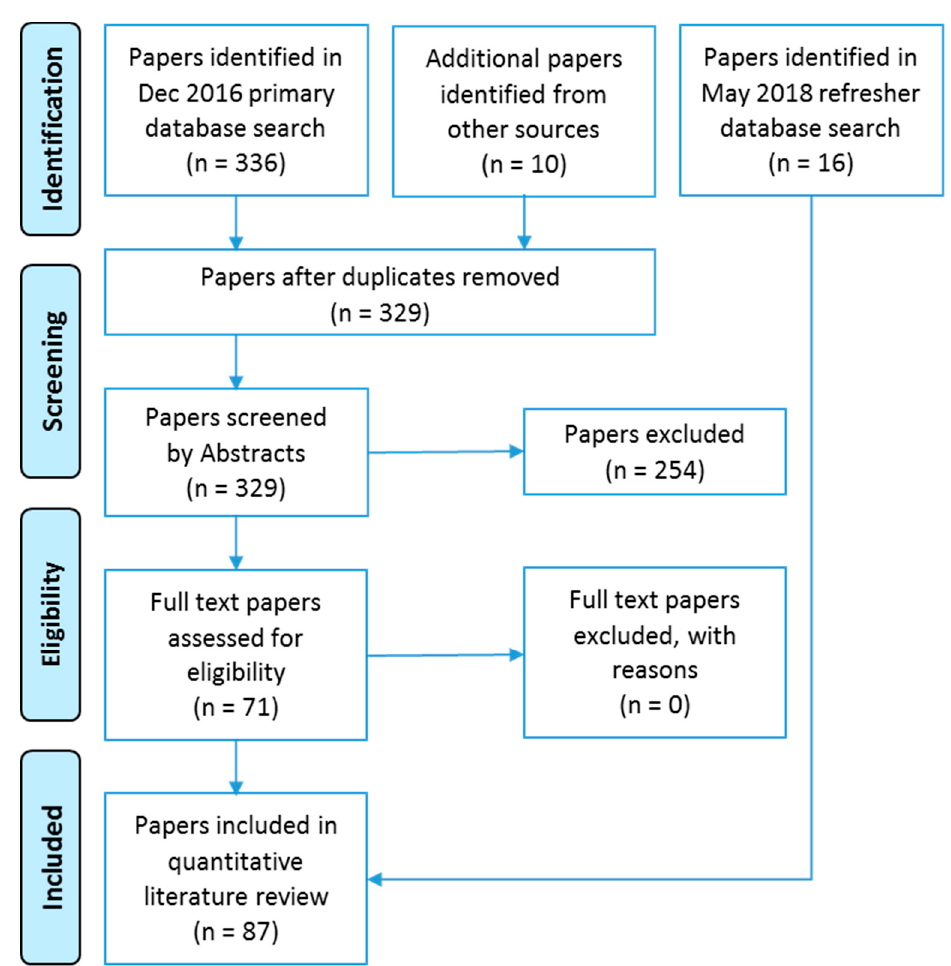
Figure 1. Preferred Reporting Items for Systematic Reviews (PRISMA) Expression for the systematic quantitative literature review. Source: Simpson and Parker [29].